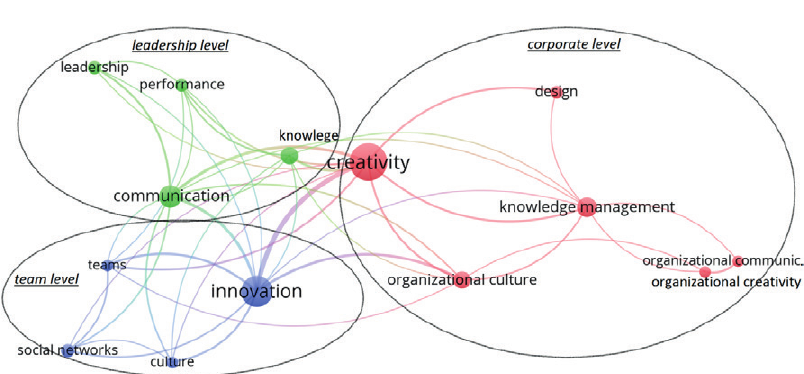
Figure 1. The categorization of research articles on organizational creativity and organizational communication using VOSviewer (source: created by authors